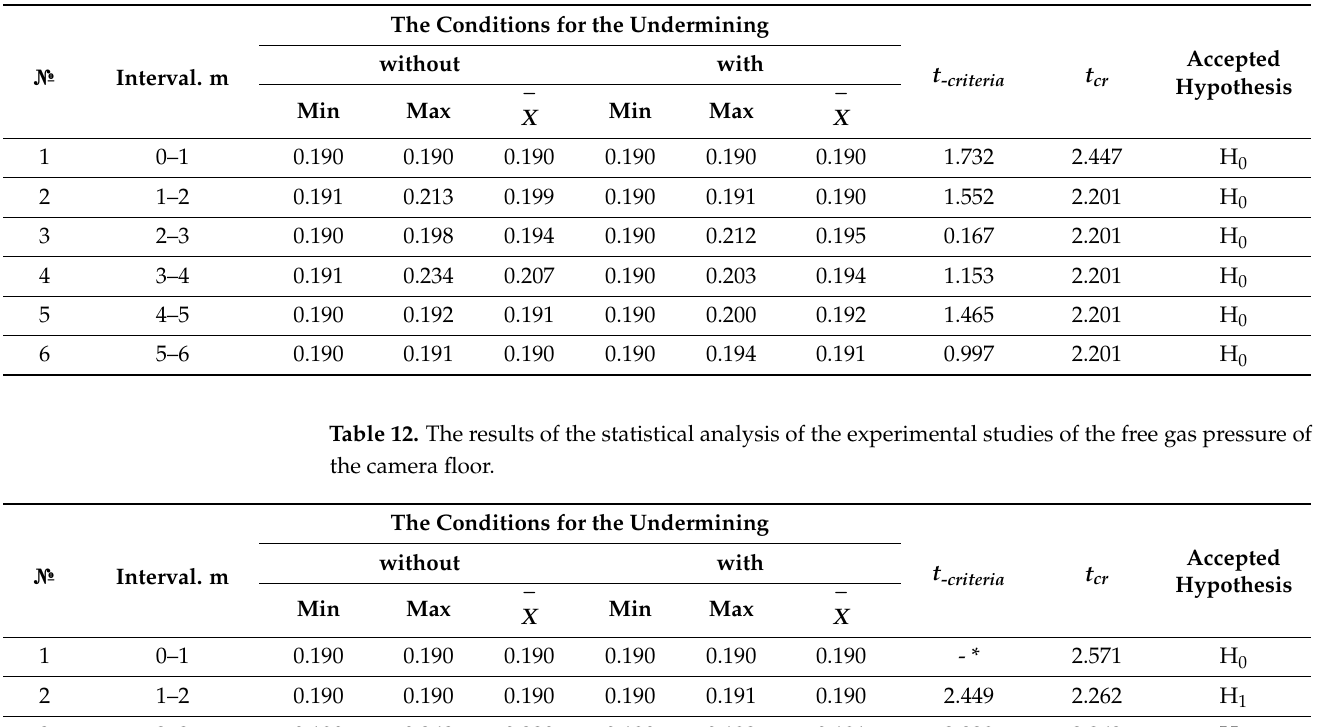
Table 11. The results of the statistical analysis of the experimental studies of the free gas pressure of the camera roof.